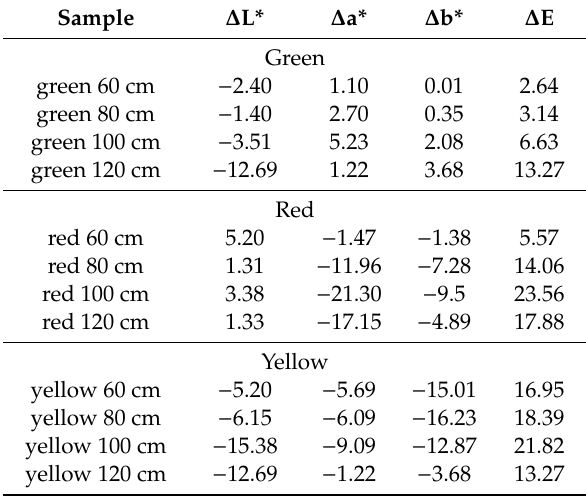
Table 1. Colorimetric data.